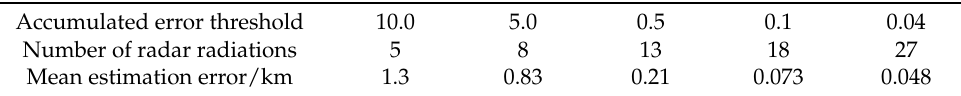
Table 3. The comparison of accumulated error thresholds.